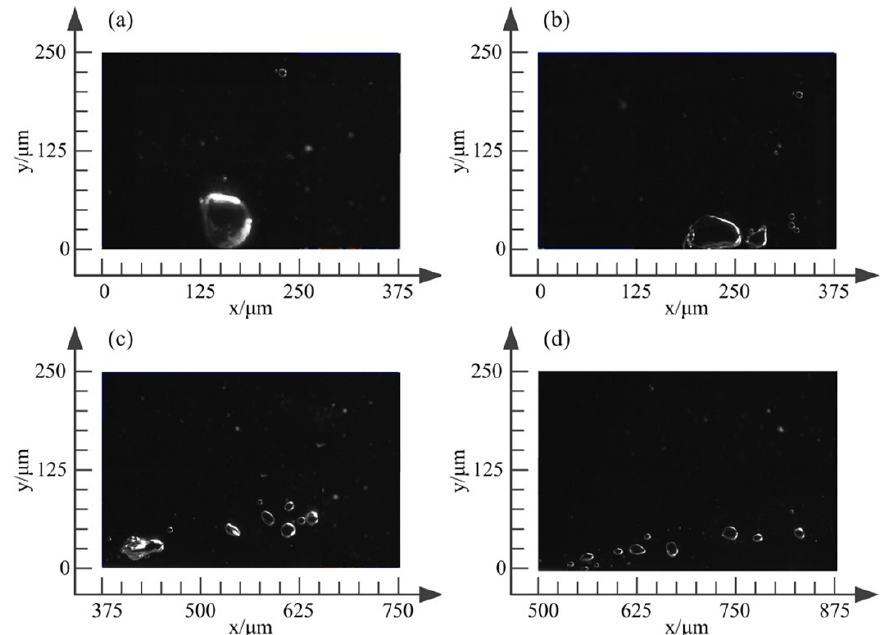
ff erent times: ( a ) t = 5 µ s,